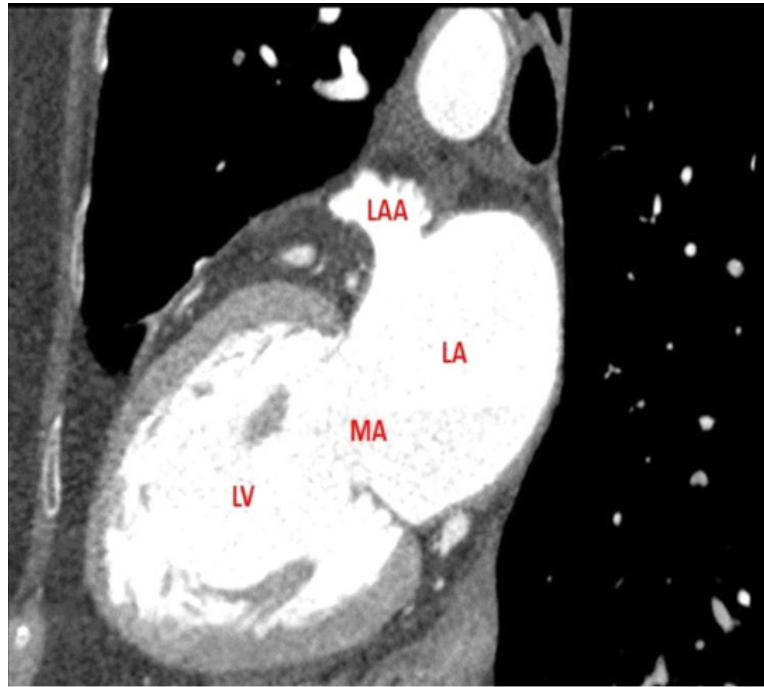
Figure 1. CT scan caption showing the absence of thrombus in the LA, including the LAA. LA: left atrium; LAA: left atrium appendage; LV: left ventricle; MA: mitral